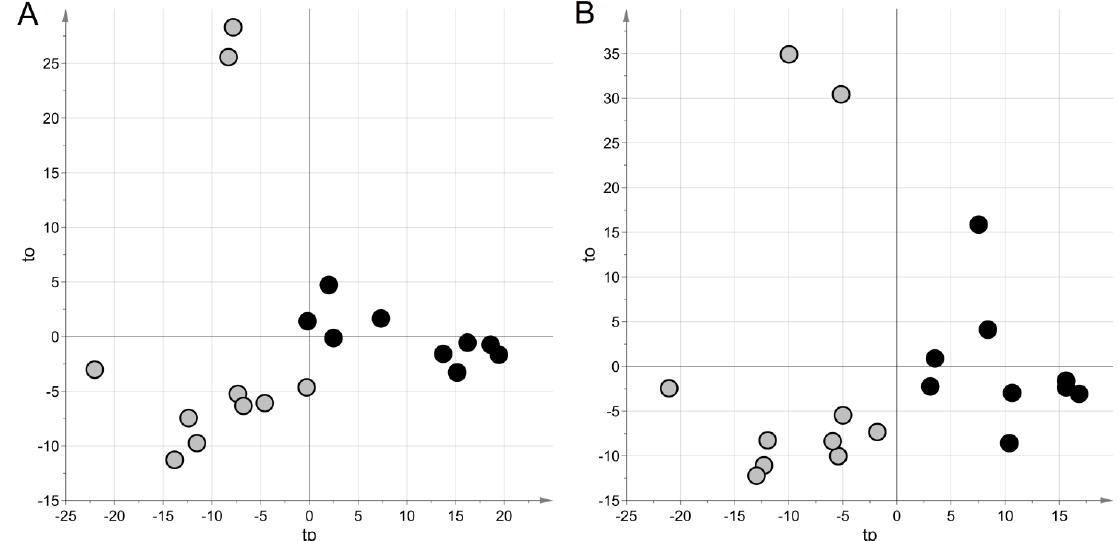
Figure 1. Untargeted metabolic profiling: score scatter plots obtained with projection to latent structures discriminant analysis(PLS–DA) modeling for urine samples. Samples from cases of sepsis are indicated with black circles, those from controls with light grey circles; panel ( A ) NEG data set; panel ( B ) POS data set. The PLS–DA models have been post-transformed to obtain the predictive latent variable tp and the non-predictive latent variable to [29]. Table 2. Annotated variables. Type: CTRL > SEPSIS indicates that the mean was higher in the control group than in the earlyonset sepsis (EOS) group; SEPSIS > CTRL indicates that the mean was higher in the EOS group than in the control AUC (CI 95%): confidence interval at the level of 95% of the area under the receiver operating characteristic (ROC)